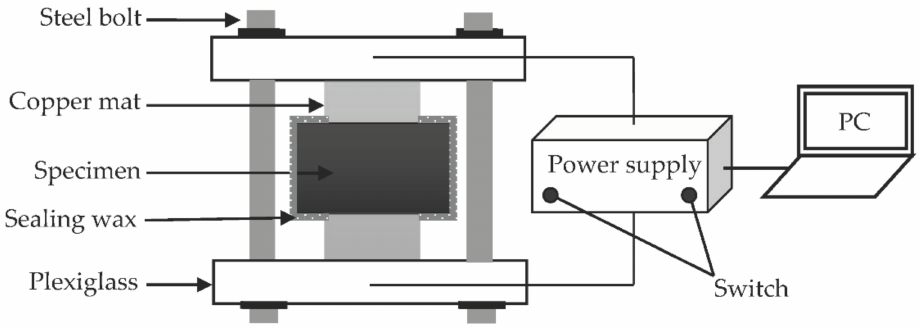
Figure 1. Schematic of test device.